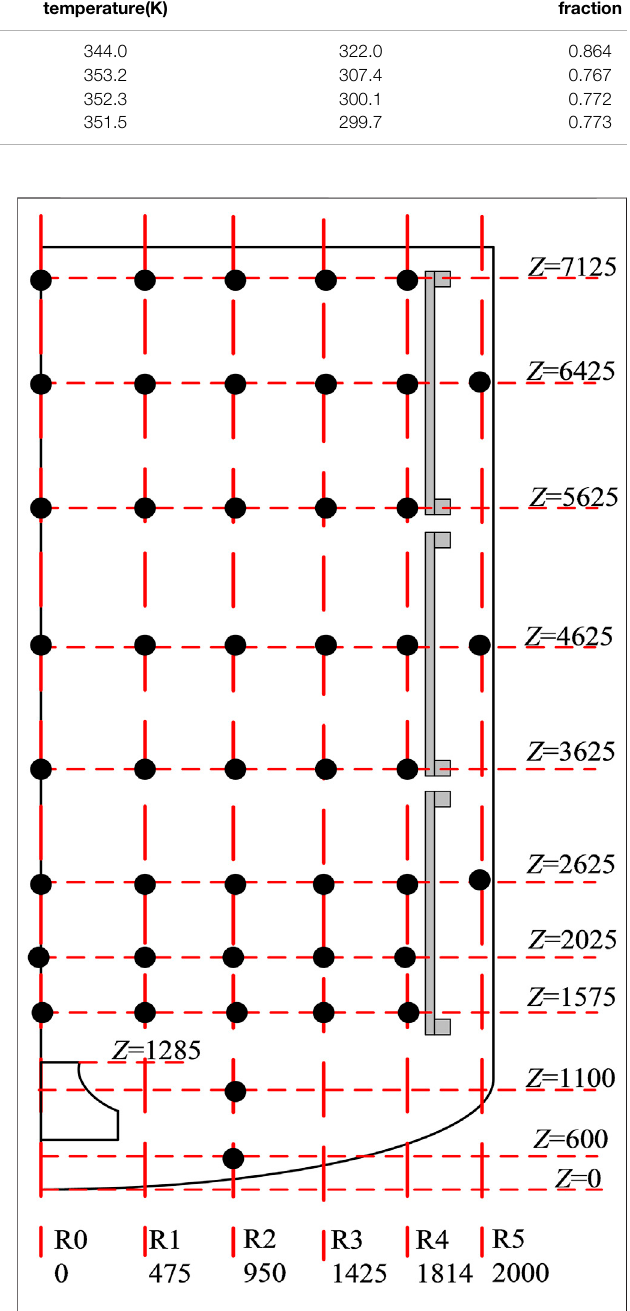
FIGURE 4 | Schematic view of the MISTRA facility and distribution of main instrumentation (Studer et al.,